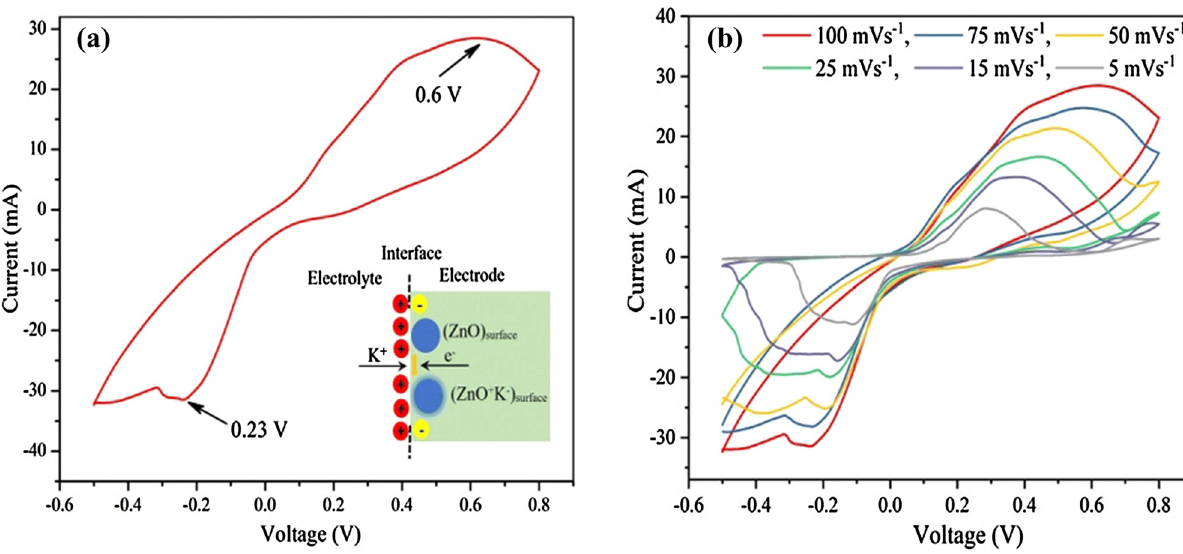
Figure 34: Electrochemical behavior ( CV ) of ZnO NPs in 0.6 M KOH at ( a ) 100 mV s − 1 and ( b ) at di ff erent scan rates. Copied with permission from ref. [ 394 ] ; Springer,